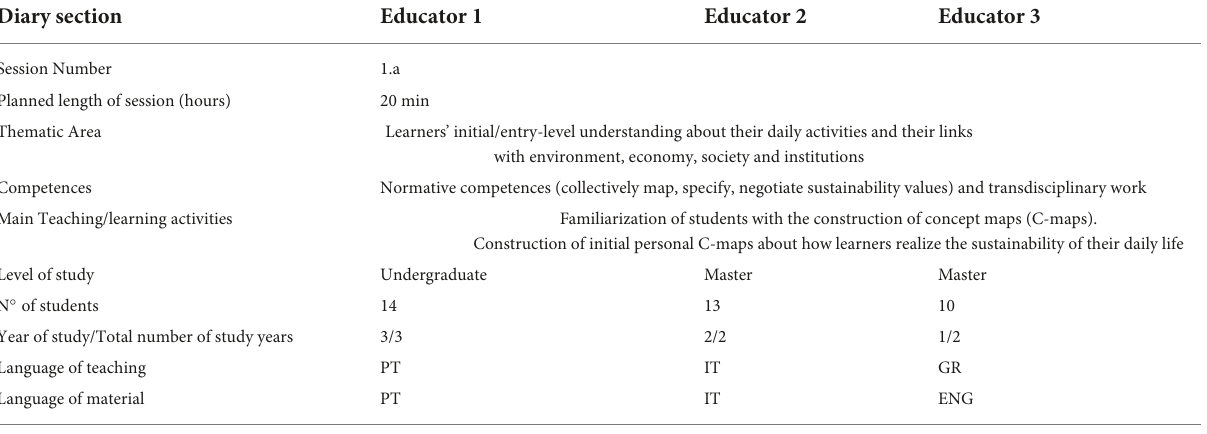
TABLE 2 Sample of the educator’s diary structure and notes from one of the sessions. General Diary